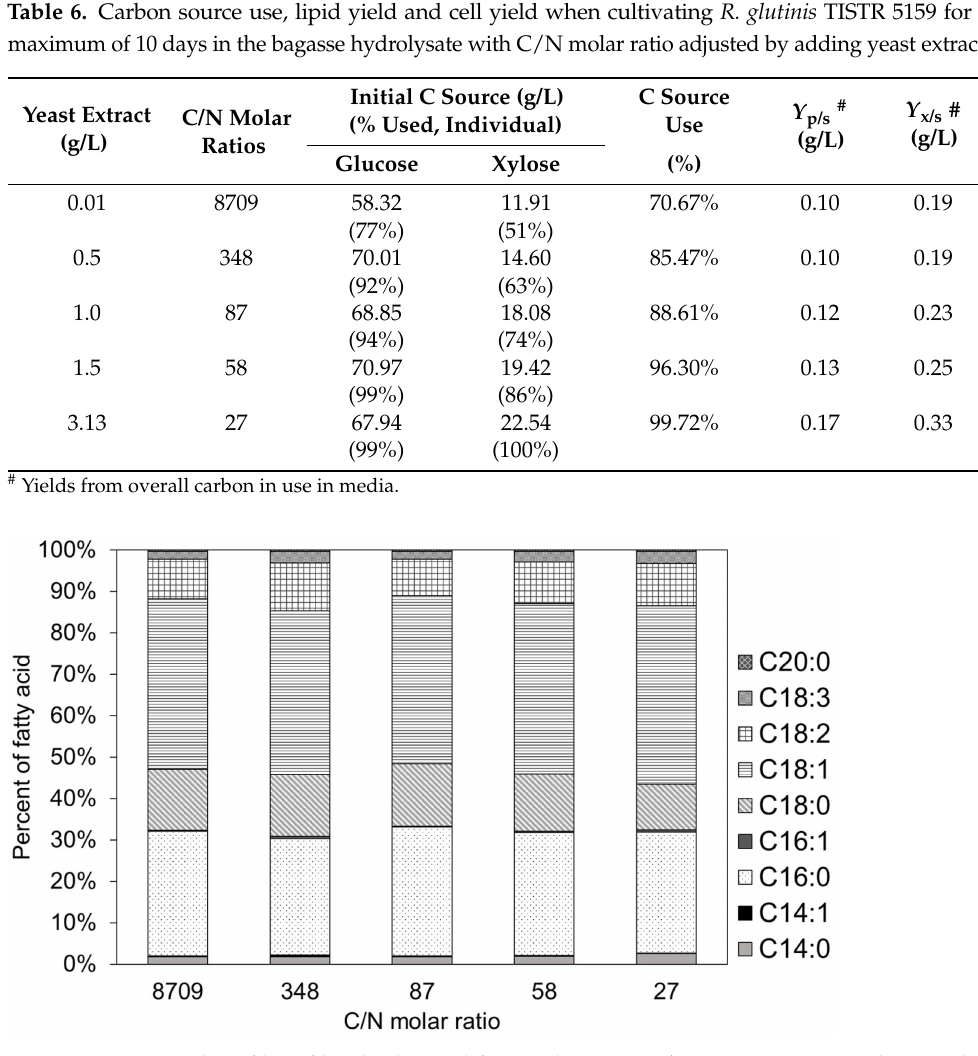
Figure 5. Fatty acid profiles of lipids obtained from culturing R. glutinis TISTR 5159 in bagasse hy- drolysate with different C/N molar ratios obtained from varying amount of yeast extract in the